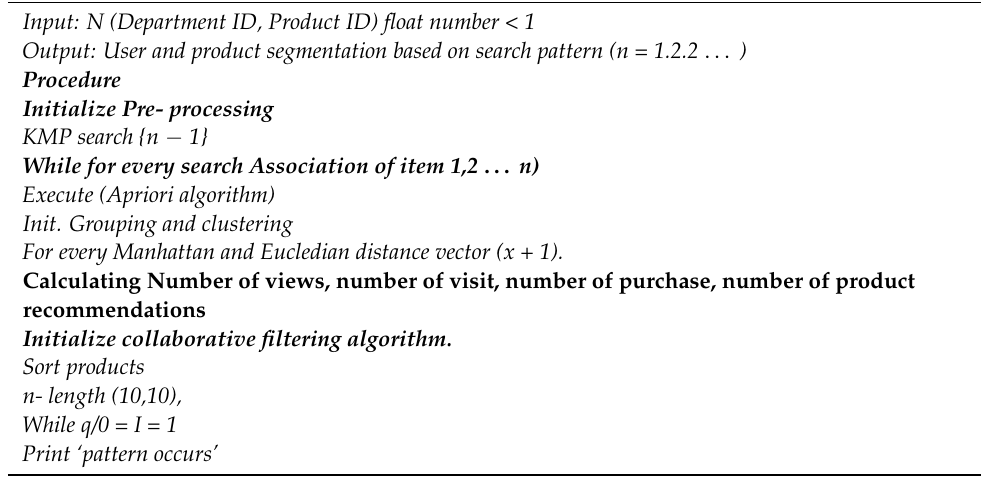
Algorithm 1: Pseuducode of transactional association with minimized error rate using KMP